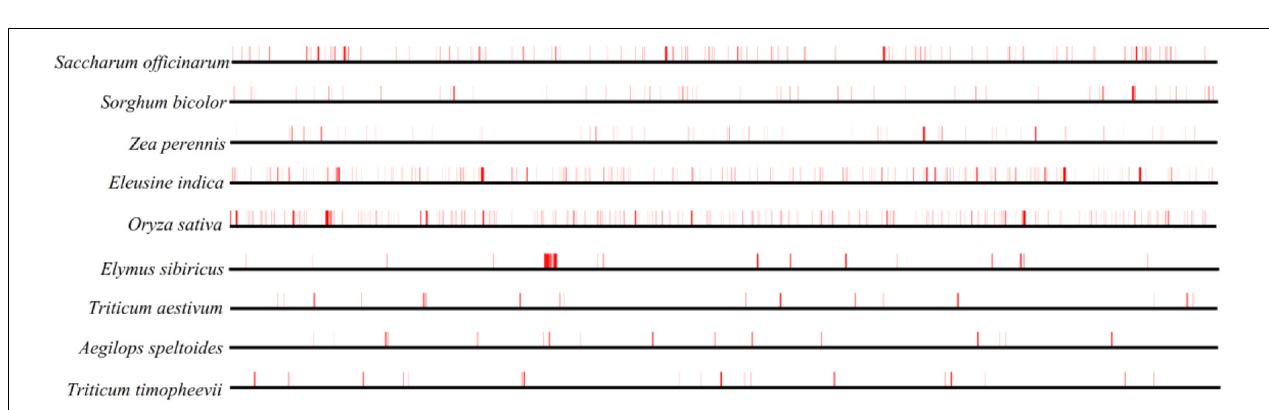
FIGURE 2 | The phylogenetic tree was constructed based on the single nucleotide polymorphisms (SNPs) and indels extracted from the 11 shared genes of Gramineae species with a bootstrap value of 1,000 using the Tamura-Nei model. The black vertical line indicates gene deletion, while the red vertical line represents gene acquisition in the same or an inferior cluster.